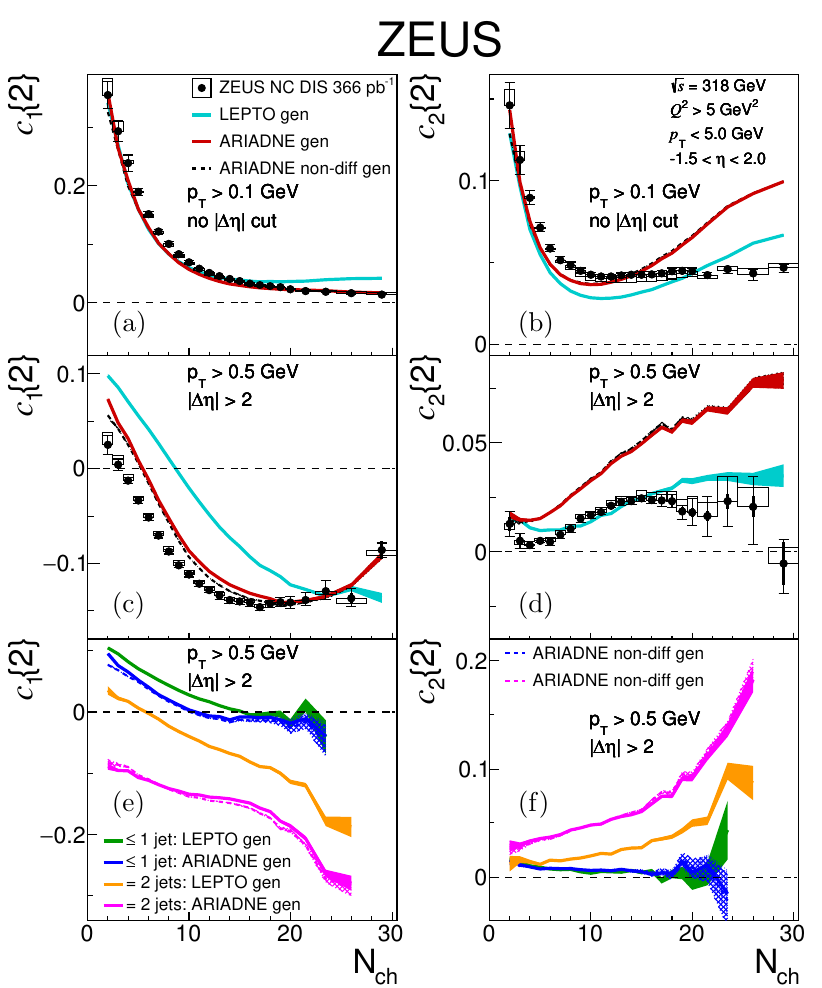
Figure 10 . Correlations c 1 f 2 g and c 2 f 2 g with and without a rapidity separation as a function of N ch compared to the predictions from Monte Carlo event generators. Correlations measured in the full kinematic interval are shown in (a) and (b), while (c) and (d) represent the interval given by p T > 0 : 5 GeV and j (cid:1) (cid:17) j > 2. Panels (e) and (f) separate out contributions from events with (cid:20) 1 jet and 2 jets. The correlation from a non-di(cid:11)ractive component in ARIADNE is shown with dashed lines. The other details are as in (cid:12)gure